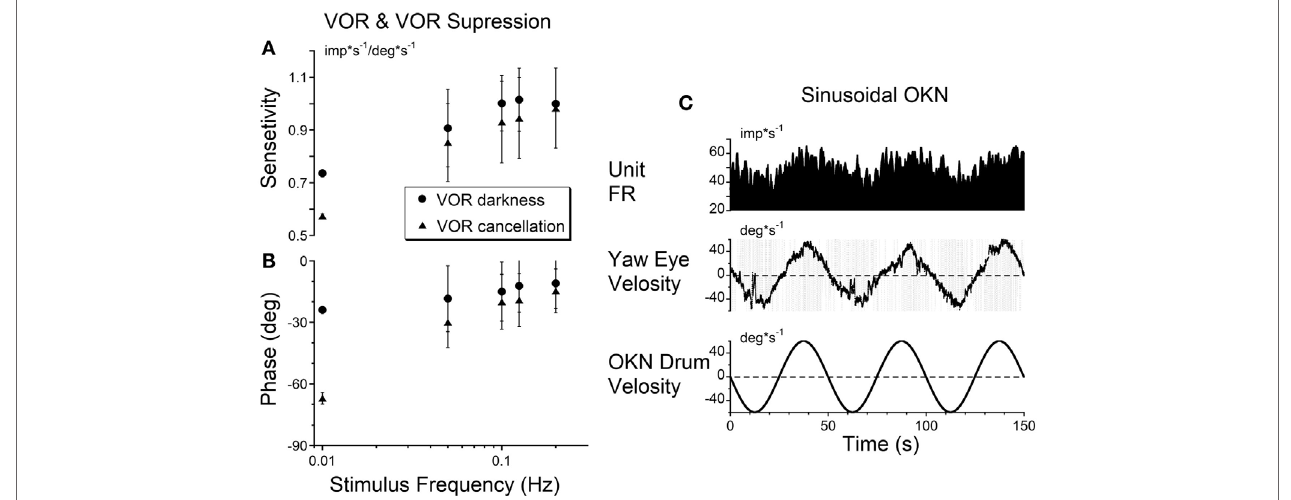
FigUre 3 | (a,B) Gains (a) and phases (B) obtained from a typical vestibular-only neuron during sinusoidal oscillation in darkness (VOR darkness, filled circles) and oscillation in light with the subject-fixed visual surround (VOR cancelation, filled triangles). (c) Activity of the same neuron recorded during sinusoidal oscillation of